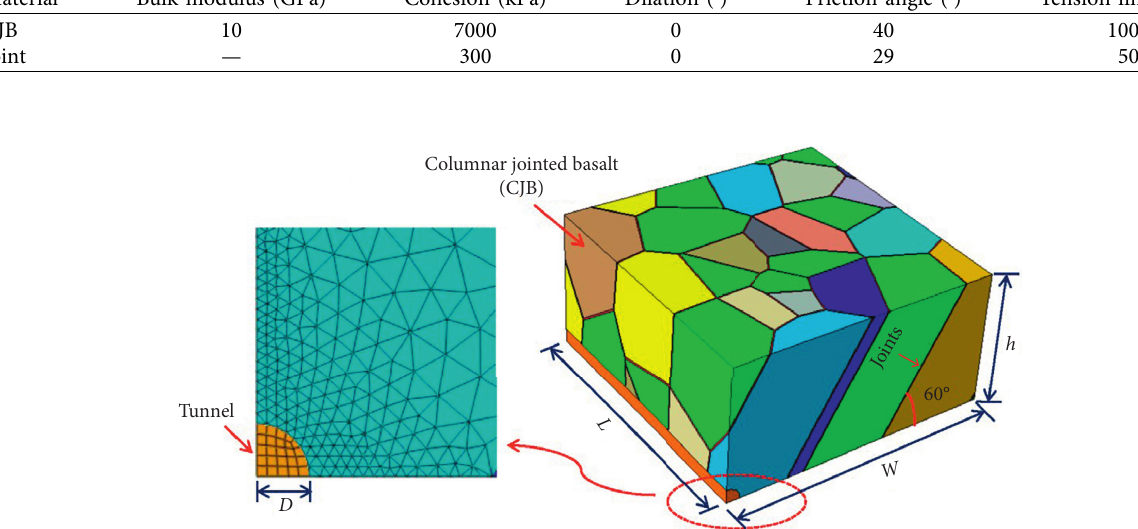
Figure 10: Numerical simulation models of tunneling in